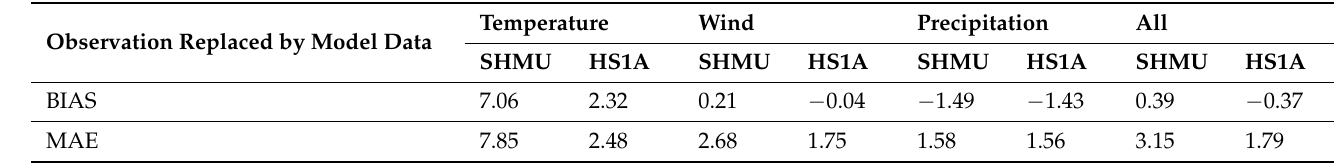
Table 9. Impact of respective parameters (2 m temperature, 10 m wind, precipitation) on the accuracy of wet snow mass (kg · m − 1 ) calculation in case the observed values were replaced by model forecasts (ALADIN/SHMU and ALADIN/HS1A) in the 19–20 April 2017 snowfall. Note that the results for “All” (all parameters replaced by model data) are slightly different from the wet snow mass forecast error in Table 7 because of the different integration time-step (1 h) compared to inline model calculations (36 s).